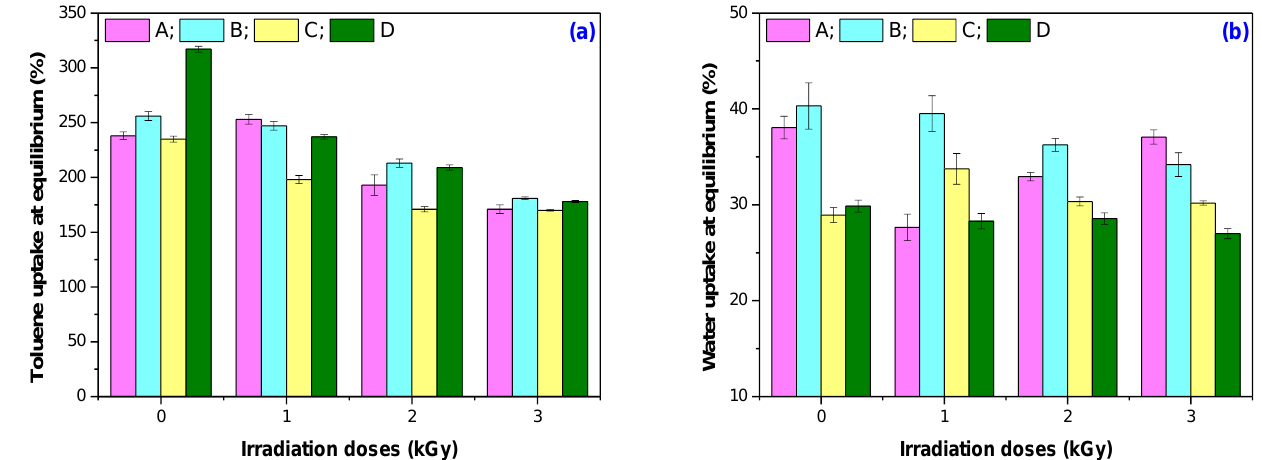
Figure 4. Toluene ( a ) and water ( b ) uptakes at equilibrium.